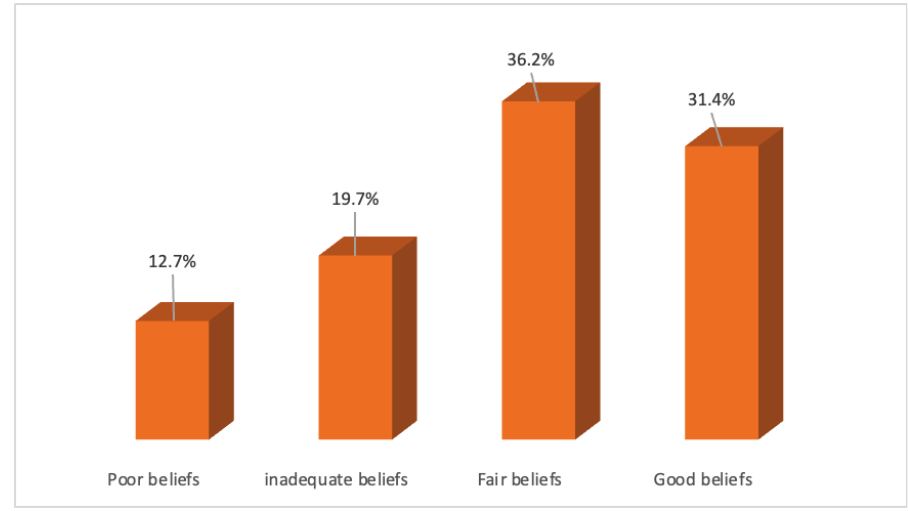
Figure 2 : Overall women’s beliefs on breast cancer at Al-Baha region. Table 4: Relationship between demographic variables, and the level of women’s awareness, n = 35.